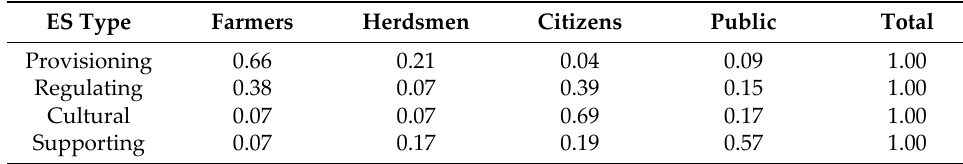
Table 3. Preference weights of different stakeholders for different